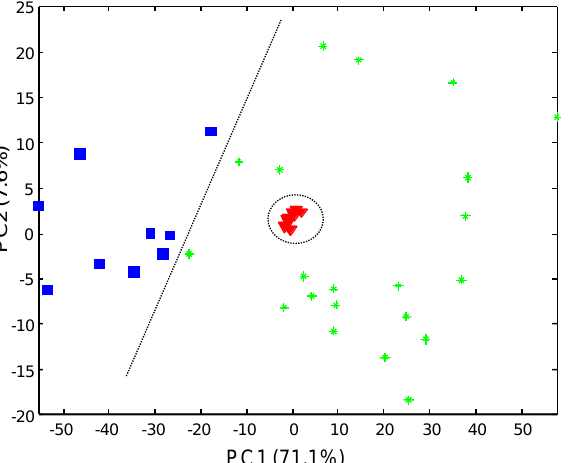
Figure 4. Map of scores of PC1 versus PC2 of turmeric and curry samples based on polyphenolic fingerprints at 280 nm. Conditions: Chromatographic method A, working time window 16.26 to 22.90 min, data dimension 30 × 1035. Sample assignment: Star = turmeric sample; square = curry sample; triangle = quality control.